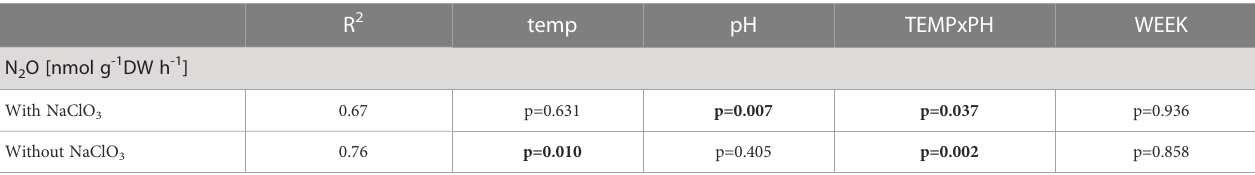
With NaClO 3 Without NaClO 3 Signi fi cance is indicated in